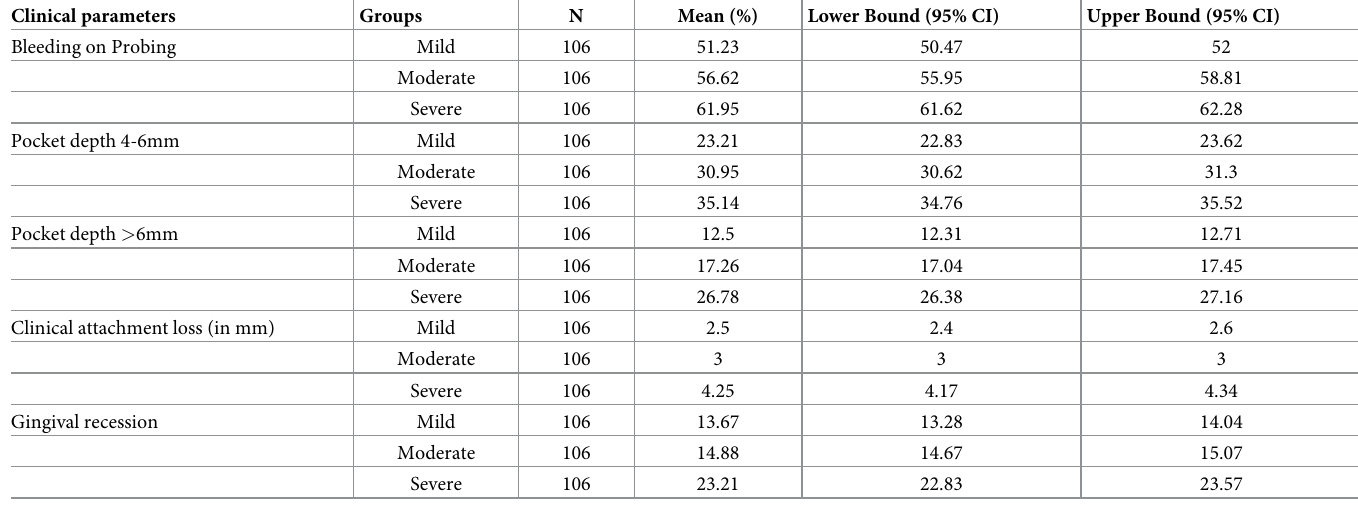
Table 3. Mean percentages of clinical periodontal parameters. Clinical